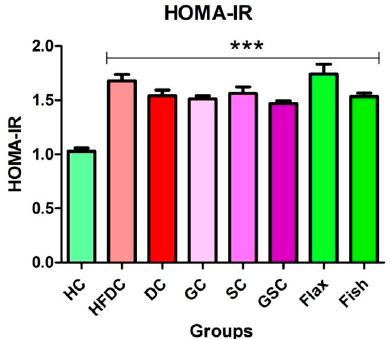
Figure 3. HOMA-IR of different experimental groups Results are represented as Mean ± SE (n = 6 for each group). *** p ≤ 0.001, when compared with the HC (Dunnett’s Multiple Comparisons Test). HC: